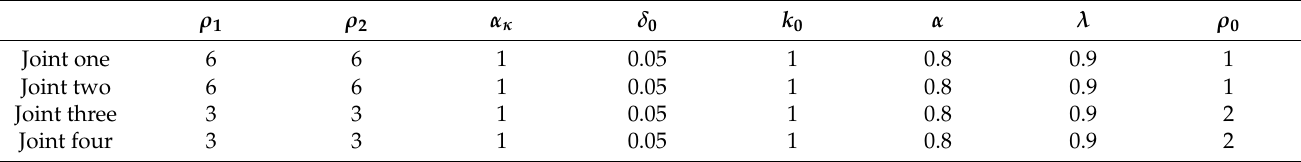
Table 11. Parameters of FONTSM-STA and FONTSM control.